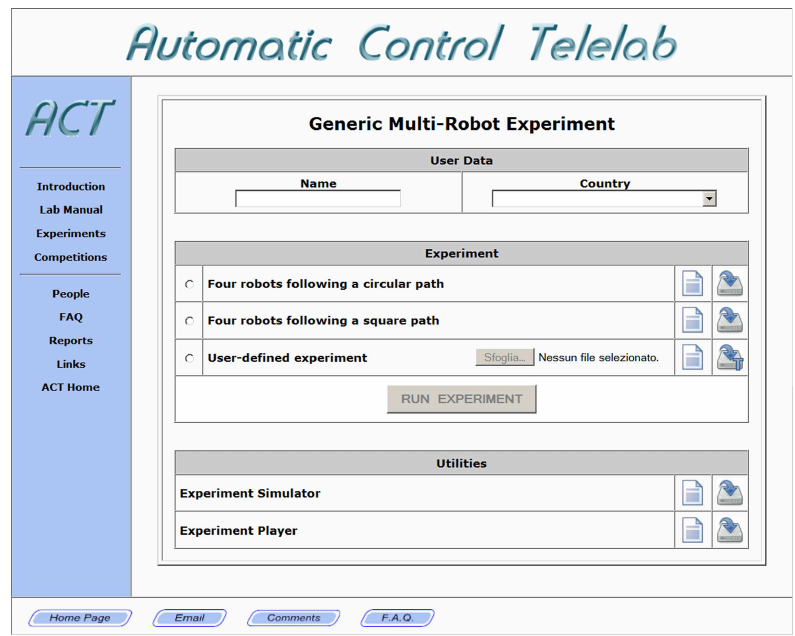
Figure 4. The Control Interface